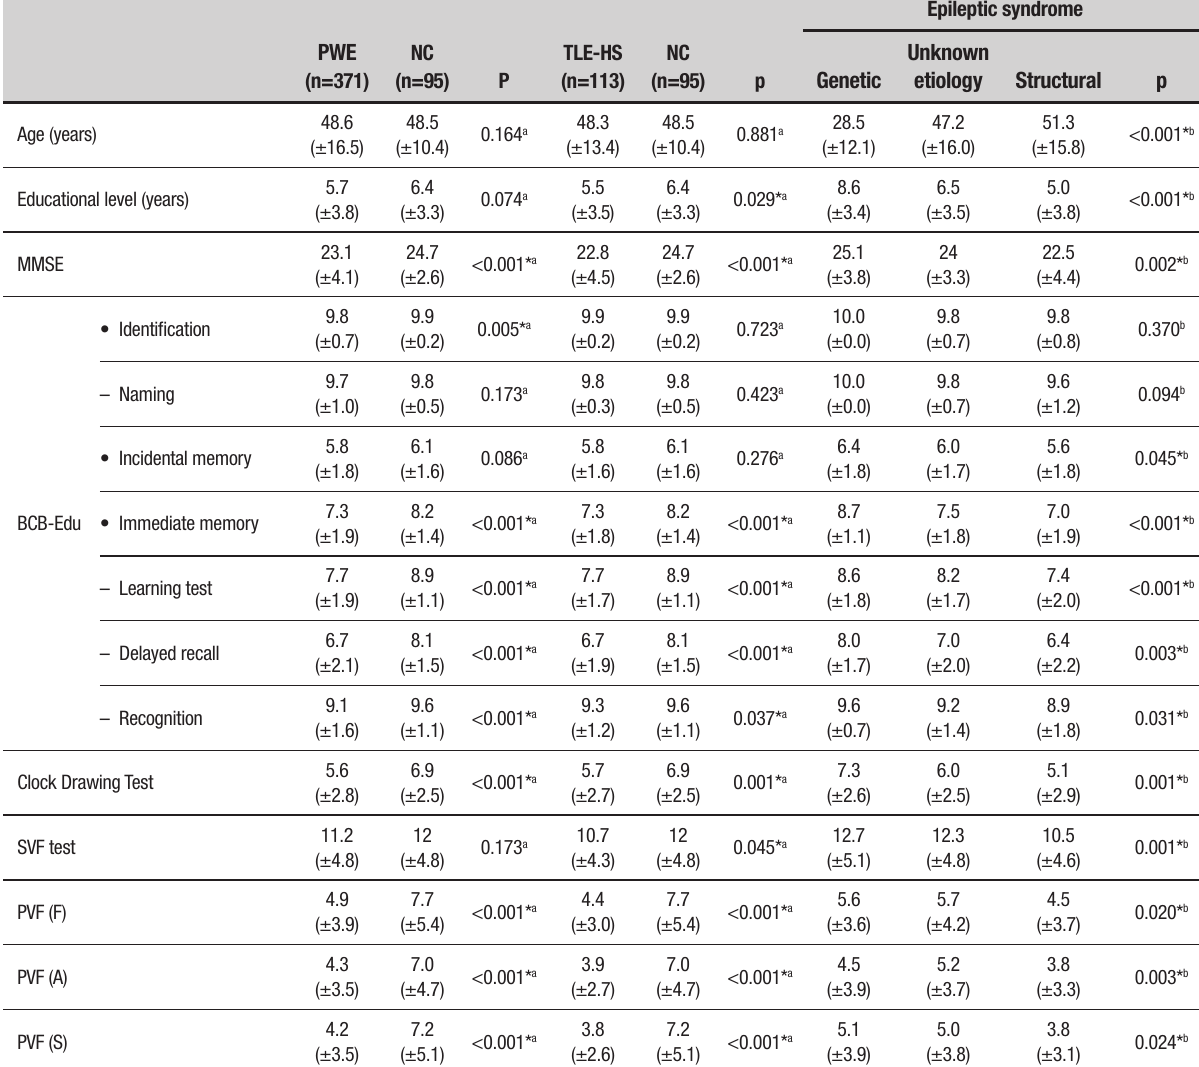
Table 2. Sociodemographic aspects and Mini-Mental State Examination and Brief Cognitive Battery-Edu scores of people with epilepsy and controls.